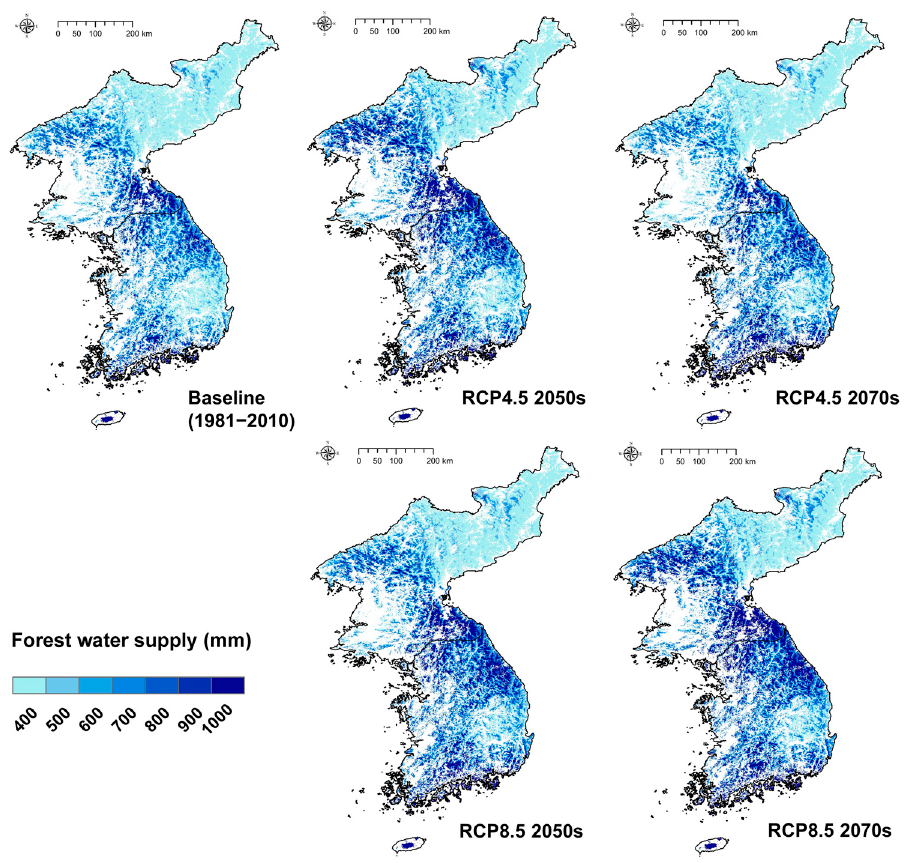
Figure 7. Forest water supply under baseline and future climate conditions in the Korean Peninsula.